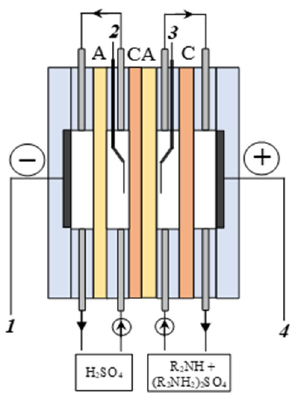
Figure 2. Scheme of an electrochemical cell for measuring the frequency spectra of the electrochemical impedance of a bipolar membrane. C—Ralex CMH cation-exchange membrane; A—Ralex AMH anion-exchange membrane; CA—the studied aMB-2m bipolar membrane; 1, 4—electrodes for the direct and alternating current polarization of the studied bipolar membrane; 2, 3—potential electrodes for measuring the alternating current potential difference across the